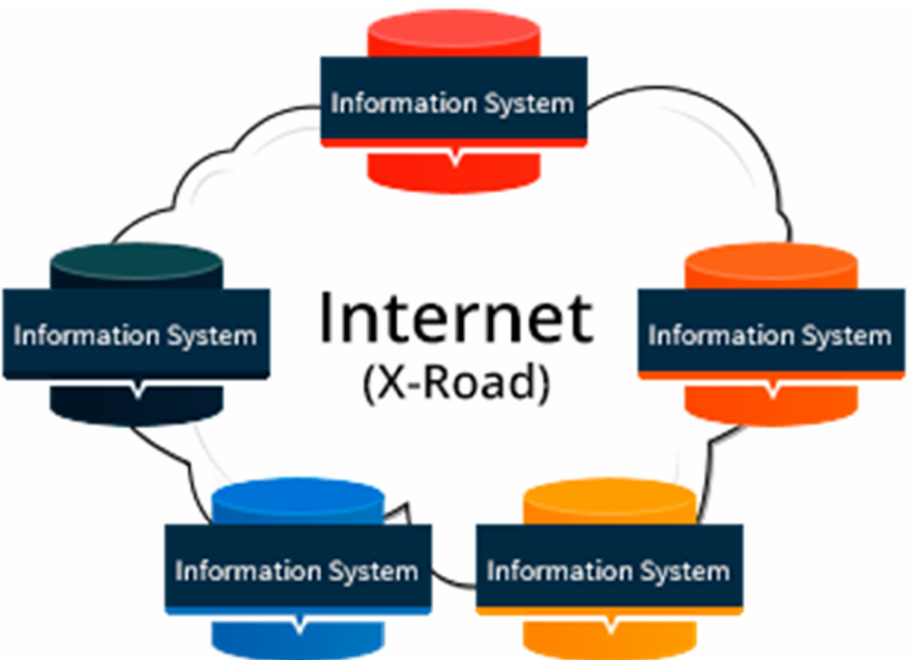
Figure 3. The X-Road platform. Source: Estonian Information System Authority. Inspired by X-Road (http://epl.delfi.ee/news/eesti/soome-votab-kasutusele-meie- x-tee-susteemi?id=67359844, accessed on 9 November 2021 (in Estonian)), Finland is